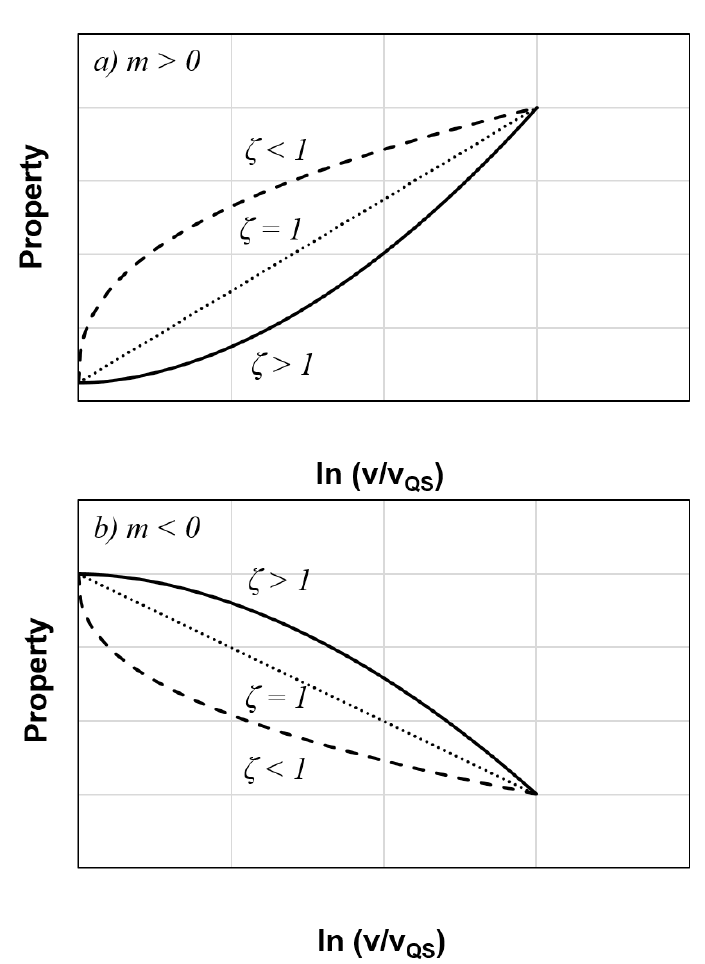
Figure 8. Illustration of the meaning of m and ζ parameters for ( a ) m > 0 and ( b ) m < 0. Table 3. Best fit parameters ( m and ζ ) and R 2 from the current study and literature.